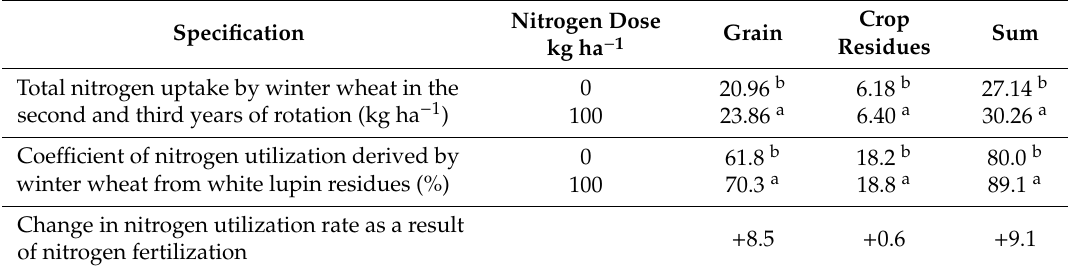
Table 6. Nitrogen uptake (kg ha − 1 ) and nitrogen-utilization coe ffi cient (%) derived from the white lupin residues taken up by winter wheat in the second and third years of the rotation (2017 and 2018).